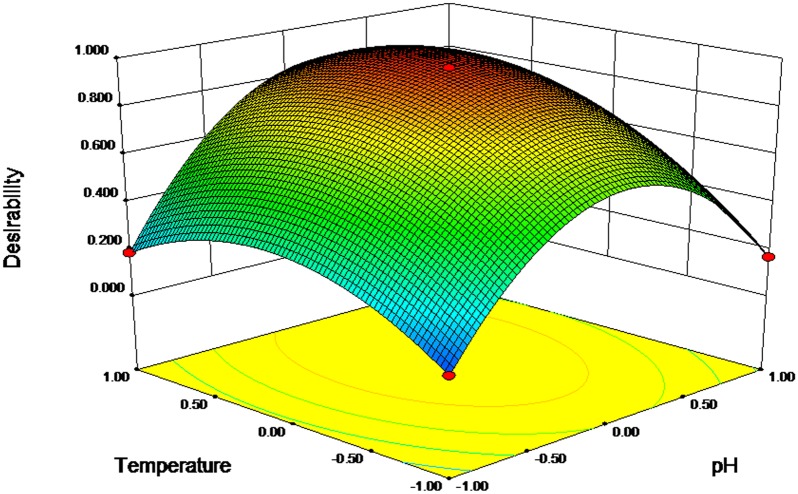
Response surface plot showing the effects of temperature and pH on diuron degradation by strain DP8-1 with inoculum at 0.55 g dry wt L‒1.